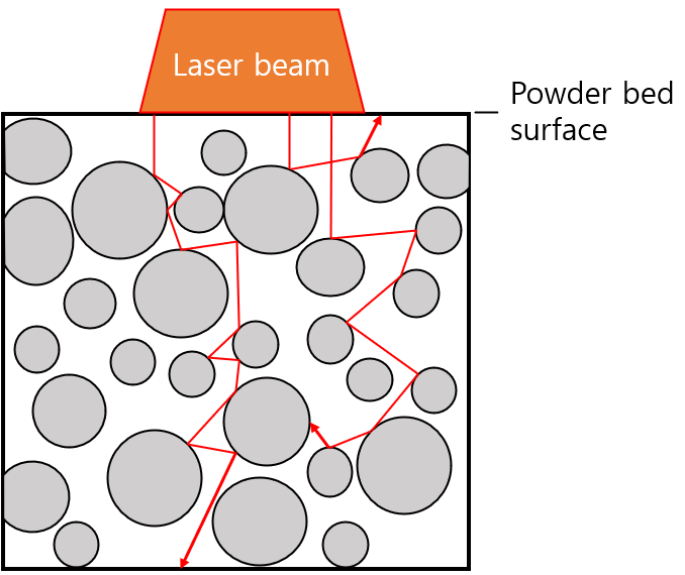
Figure 4. Interaction of laser and powder bed in the SLM process.